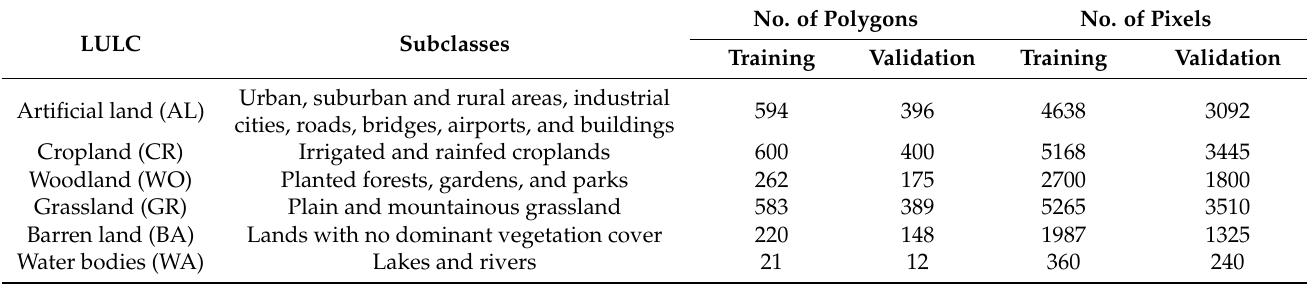
Table 1. The characteristics of land use/land cover (LULC) classes (pixel resolution = 10 m).